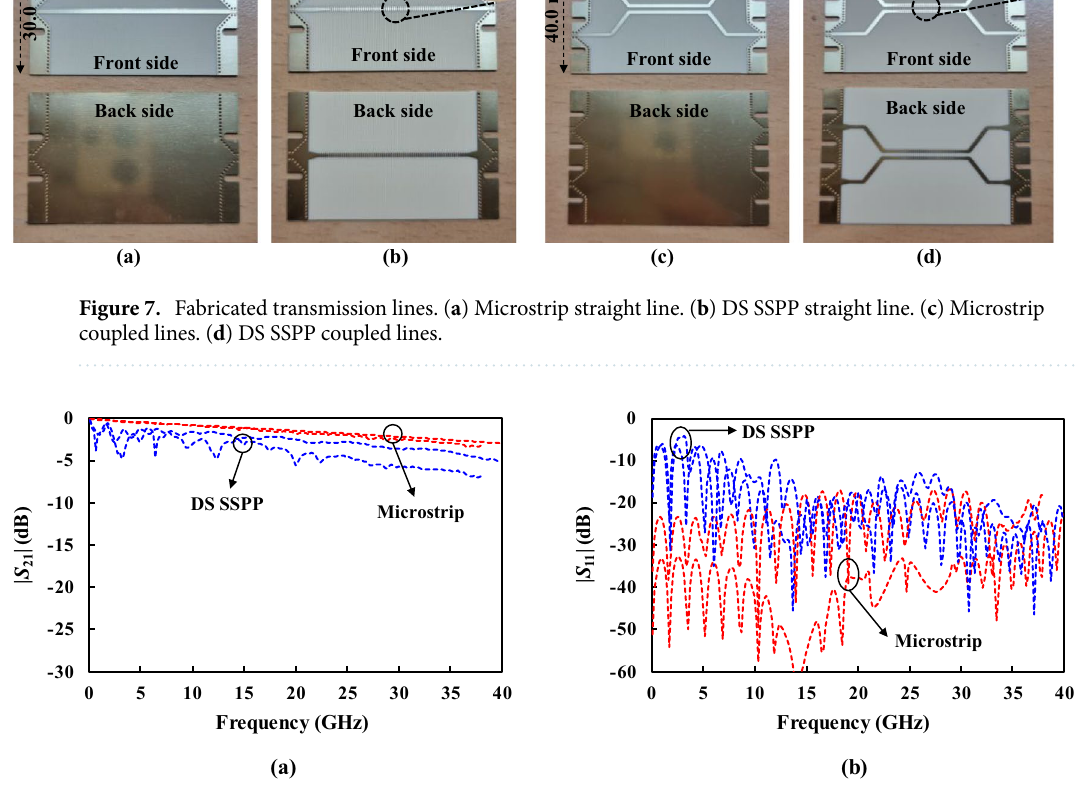
Figure 8. Measured (solid) and simulated (slotted) results of microstrip and DS SSPP lines. ( a ) | S 21 | . ( b ) | S 11 |